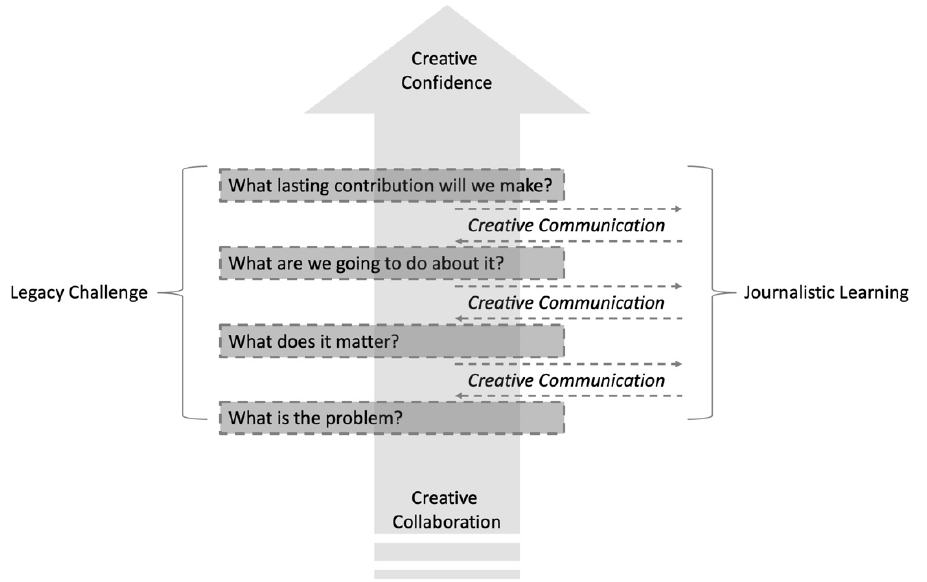
Figure 1. Journalistic Legacy Challenges.